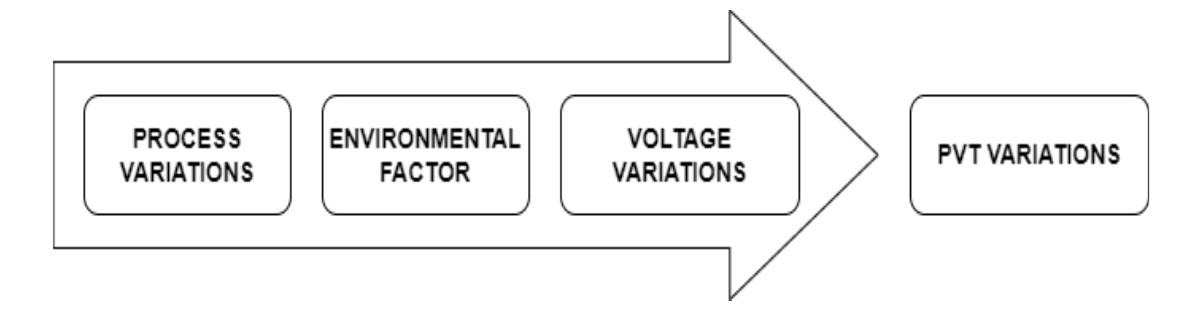
Figure 4. PVT changes in FinFET devices.